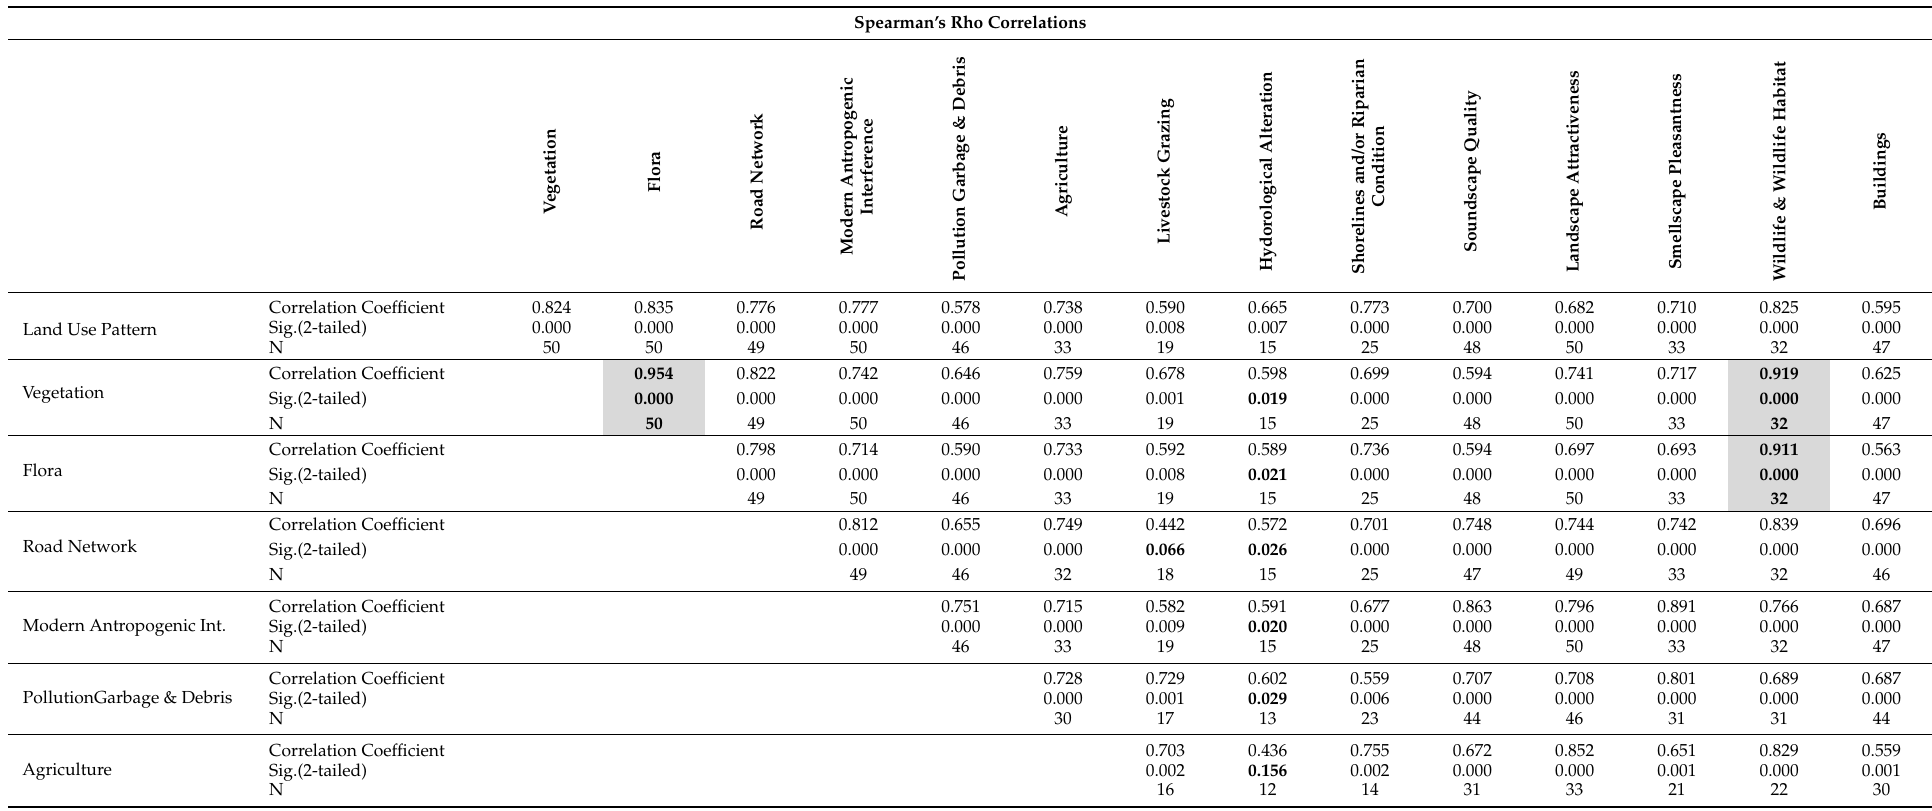
Table A3. Correlation analyses using Spearman’s rho. (Outstanding values are in